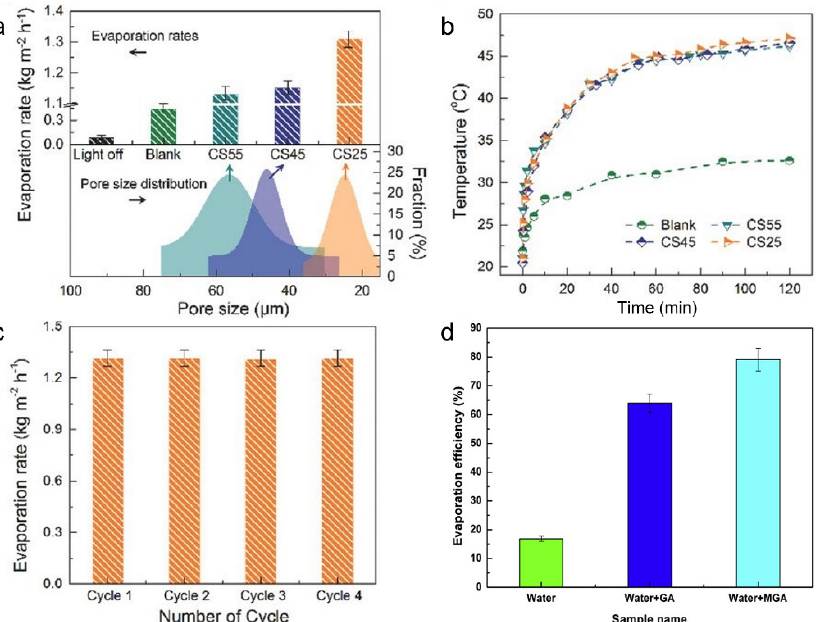
Figure 3. The evaporation rates ( a ) and surface temperature changes ( b ) of different CS at an optical density of 1 kW m − 2 . ( c ) Stability and reusability of CS25 for steam generation. Reprinted with permission from ref. [91]. Copyright 2018 Wiley-VCH. ( d ) The evaporation efficiency of different samples under 1 kW m − 2 solar irradiation. Reprinted with permission from ref. [93]. Copyright 2018 Elsevier.